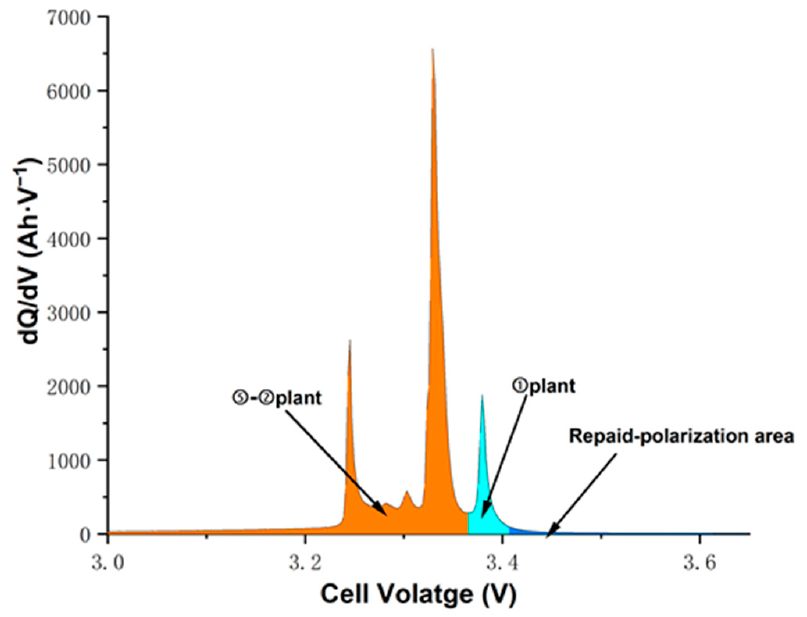
Figure 10. IC curve of retired LiFePO 4 battery.